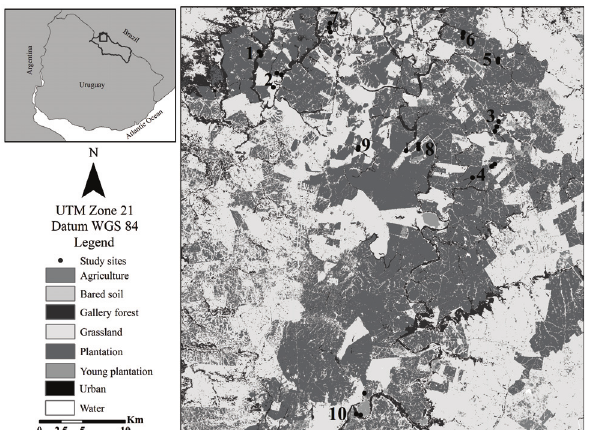
Figure 1. Map of Uruguay showing the location of the study area (red or black square) in the department of Rivera, and a land-use map showing the ten forestry company properties where a forest, a plantation and a grassland site were